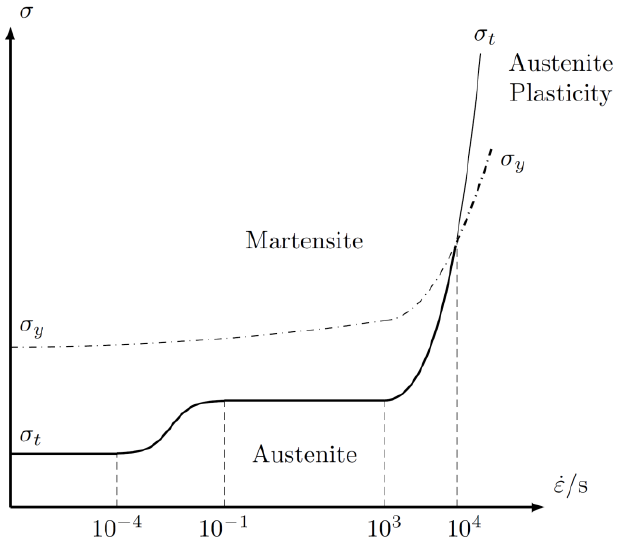
Figure 2. A general plot of the martensitic transformation stress ( 𝜎 𝑡 ) and the austenite yield stress ( 𝜎 𝑦 ) as functions of the strain rate.